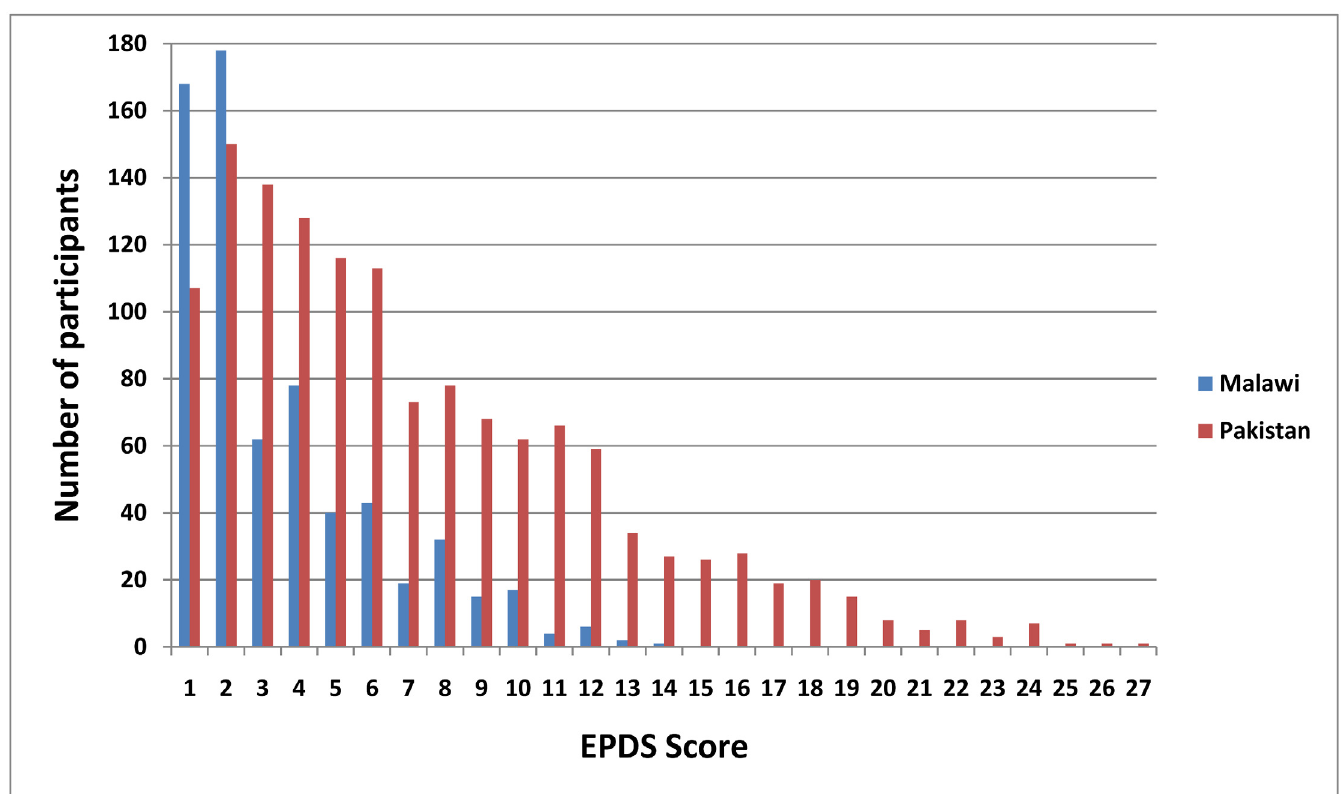
Fig 1. Distribution of EPDS scores for rural women in Malawi and